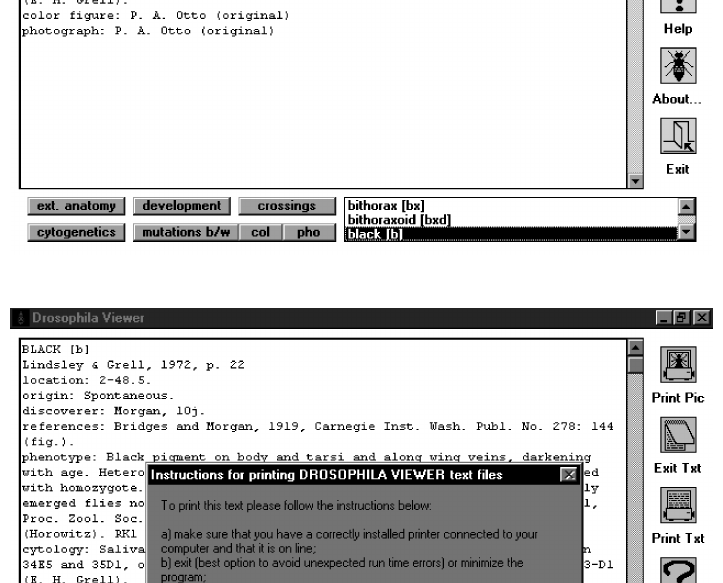
Figure 12 - Instructions for printing the selected text. When a text is open in the main window, the keying of the figure “Print T(e)xt” shows a window with summary procedures to obtain plain or formatted text. Alternatively, the text shown on the screen can be highlighted with the left mouse button and cop- ied (ctrl + C) to the computer clipboard to be transferred to a word processor and printed